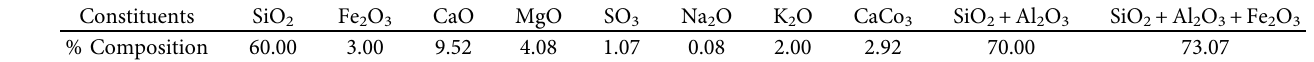
Table 3: Chemical properties of coffee husk ash (CHA) fillers [28].